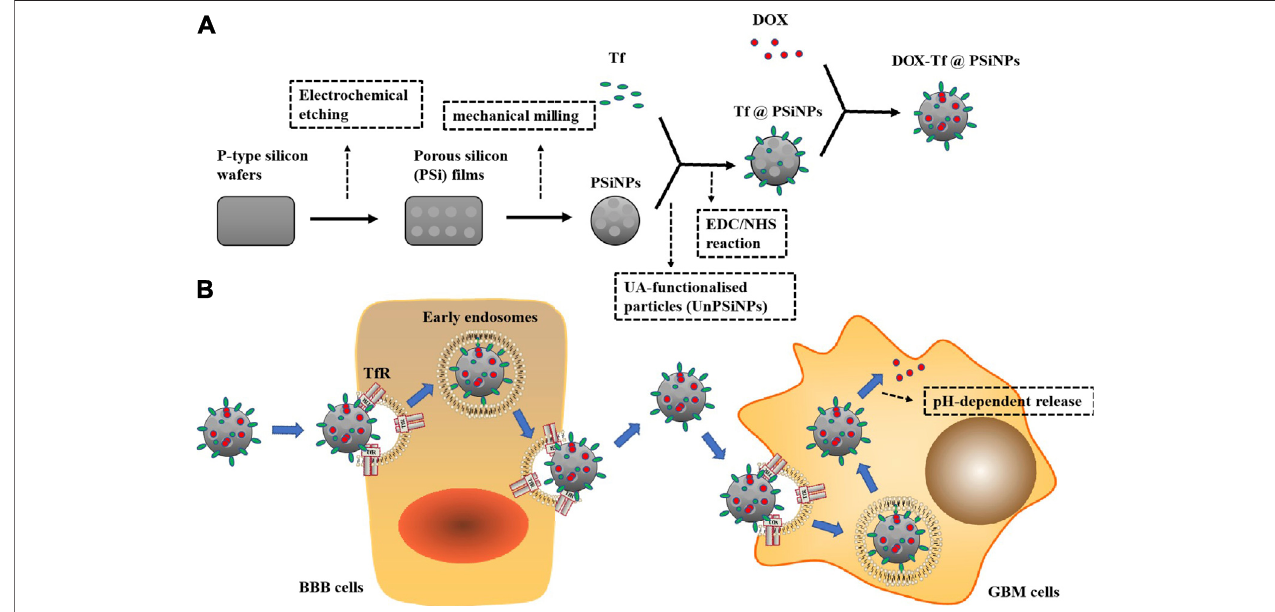
FIGURE 1 | Construction, uptake, release, and ef fi cacy of DOX-Tf@PSiNPs. (A) P-type silicon wafers are used to prepare porous silicon (PSi) fi lms by electrochemicaletching,and PSiNPs areformed bymechanical milling. UA-functionalizedPSiNPs (UnPSiNPs)conjugate Tfthroughatwo-step EDC/NHSreaction,and